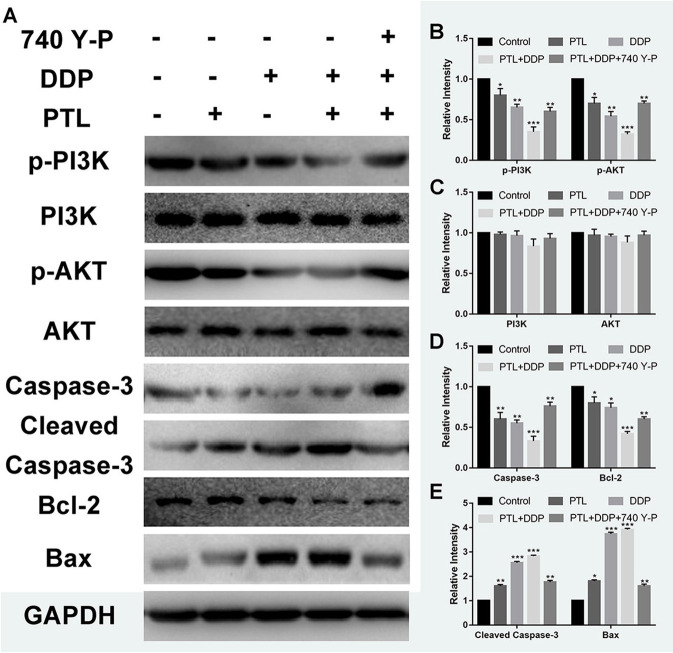
Suppressive effect of PTL, DDP, and the combination on the PI3K/AKT signaling pathway in A549 cells. Protein expression levels of p-PI3K, PI3K, p-Akt, Akt, Caspase-3, cleaved Caspase-3, Bcl-2, Bax, and GAPDH in A549 cells treated with 30 μM PTL, 0.75 μM DDP alone, and 0.2 μM DDP and 10 μM PTL in combination with or without 30 μM 740 Y-P for 48 h (A). Histograms depicting the relative gray value of the related proteins measured using ImageJ (B–E). All data are shown as the mean ± SD of three independent experiments. *P < 0.05, **P < 0.01 or ***P < 0.001 vs. the control group.